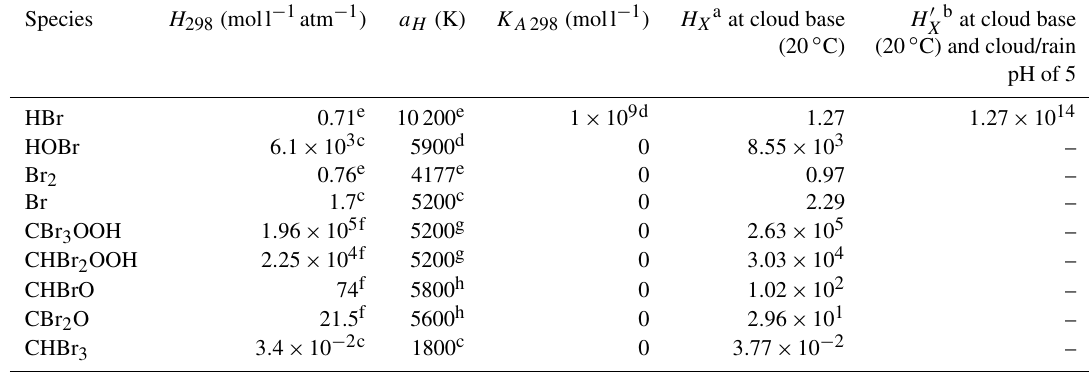
Table 1. Values used in the determination of the Henry law constants H X a and effective Henry constants H (cid:48) the model.